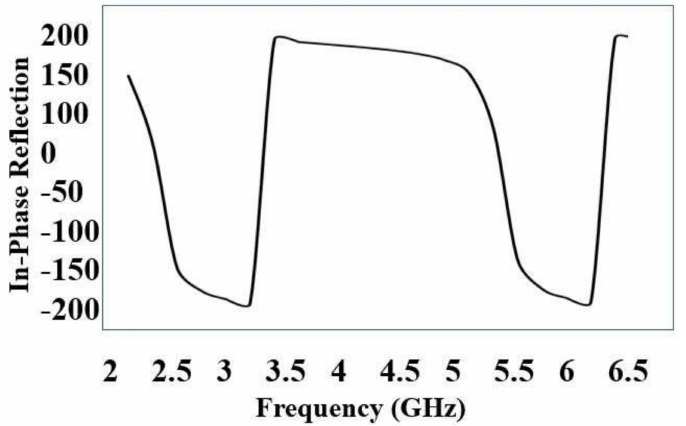
Figure 6. In-phase reflection of SRR unit cell.